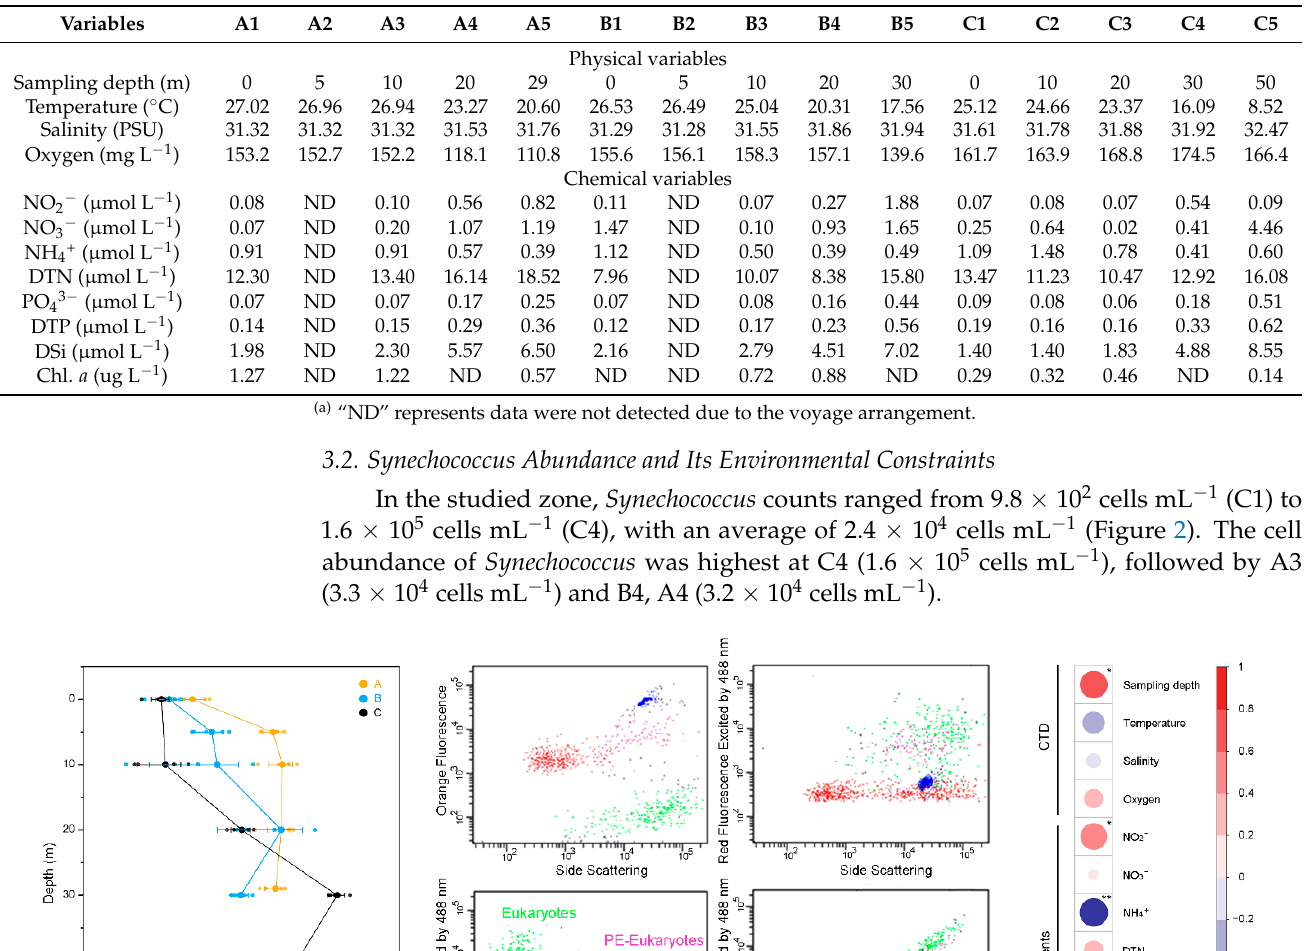
Table 1. Physicochemical variables of each sample (a) .